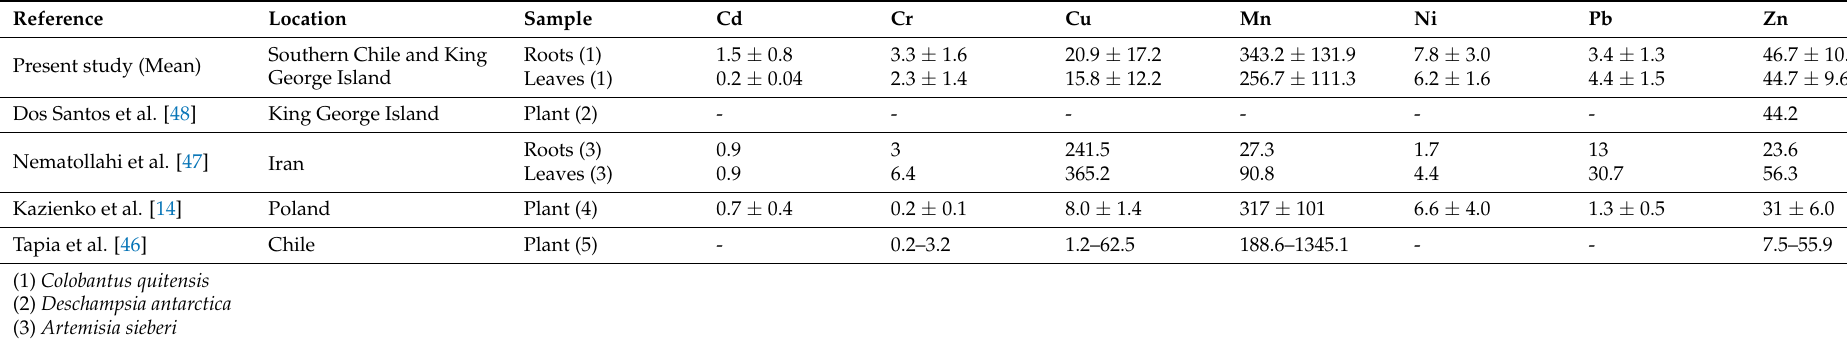
Table 2. Selected references of MTE concentrations (mg/kg in dry weight) in vegetables. Values are mean ± standard deviation and